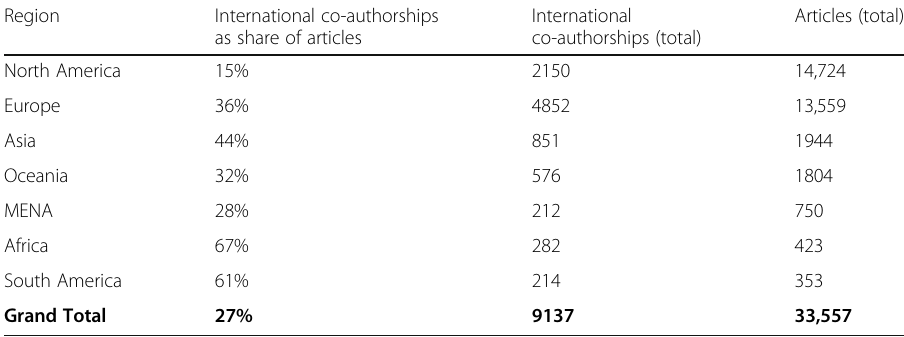
Table 1 International co-authorships by region, 1998 – 2018 (only countries with over 30 articles)